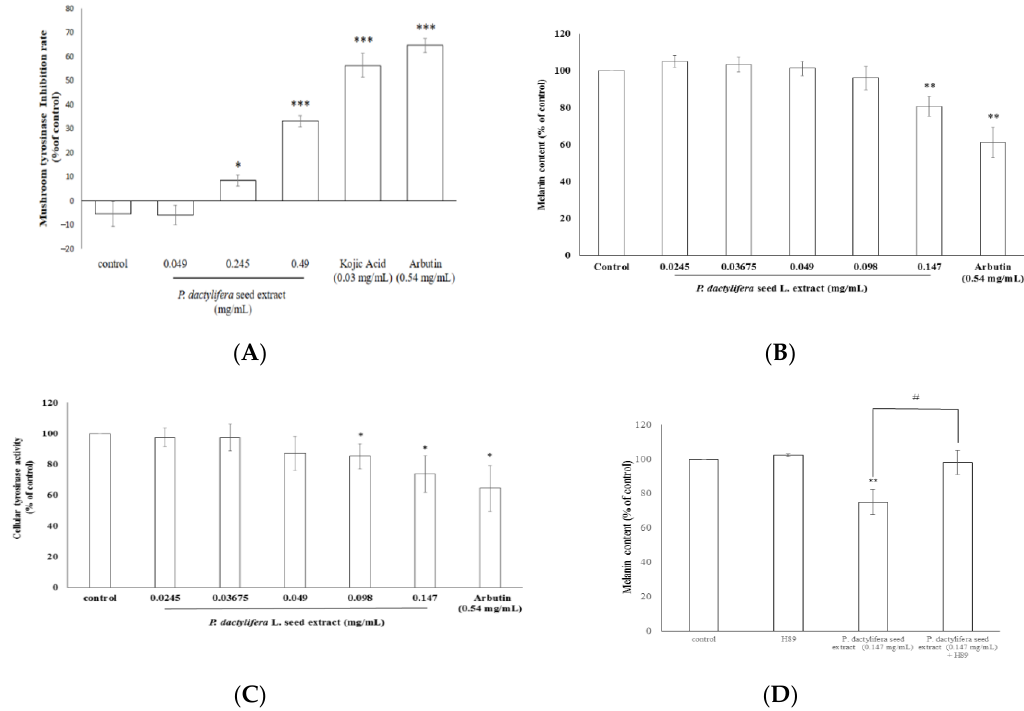
Figure 4. The inhibitory effects of P. dactylifera L. seed extract on melanogenesis. ( A ) The effects of P. dactylifera L . seed extract on mushroom tyrosinase activity. ( B ) The effects of P. dactylifera L. seed extract on melanin content in B16F10 cells. ( C ) The effects of P. dactylifera L . seed extract on B16F10 tyrosinase activity. ( D ) The PKA inhibitor (H89) assay. The values are significant as compared with the control. * p < 0.05, ** p < 0.01, *** p < 0.001, # p < 0.05 seed extract (0.147 mg/mL) vs. seed extract (0.147 mg/mL) + H89.